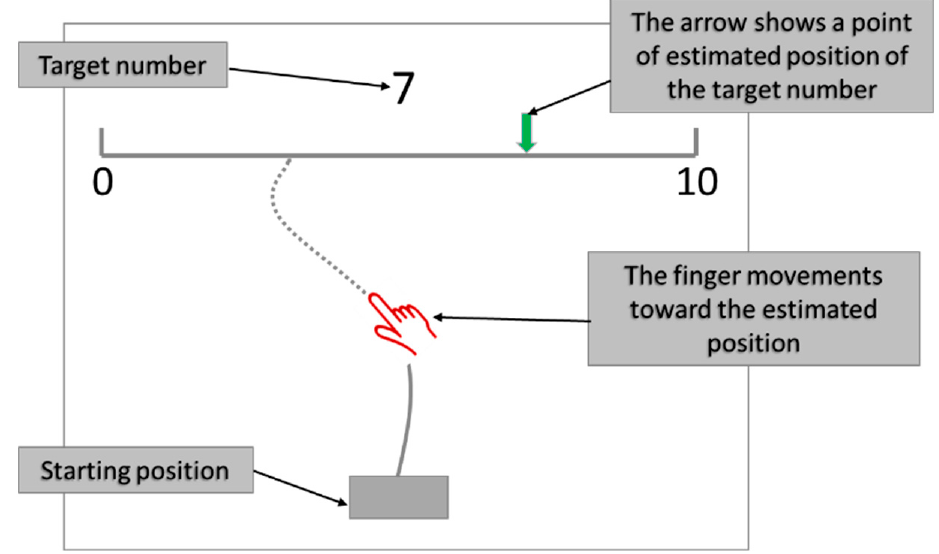
Figure 4. A schematic example of the task with a participant’s finger movement.